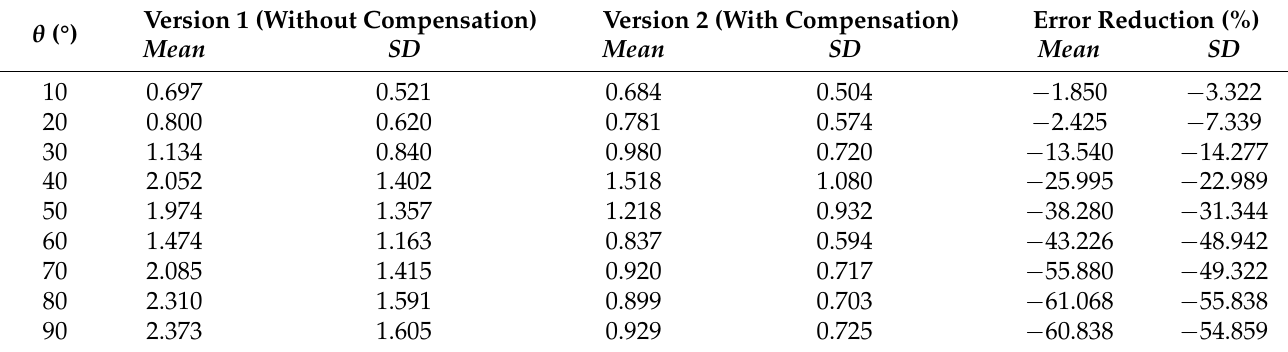
Table 3. The numerical results of direction angle error in 210° FoV